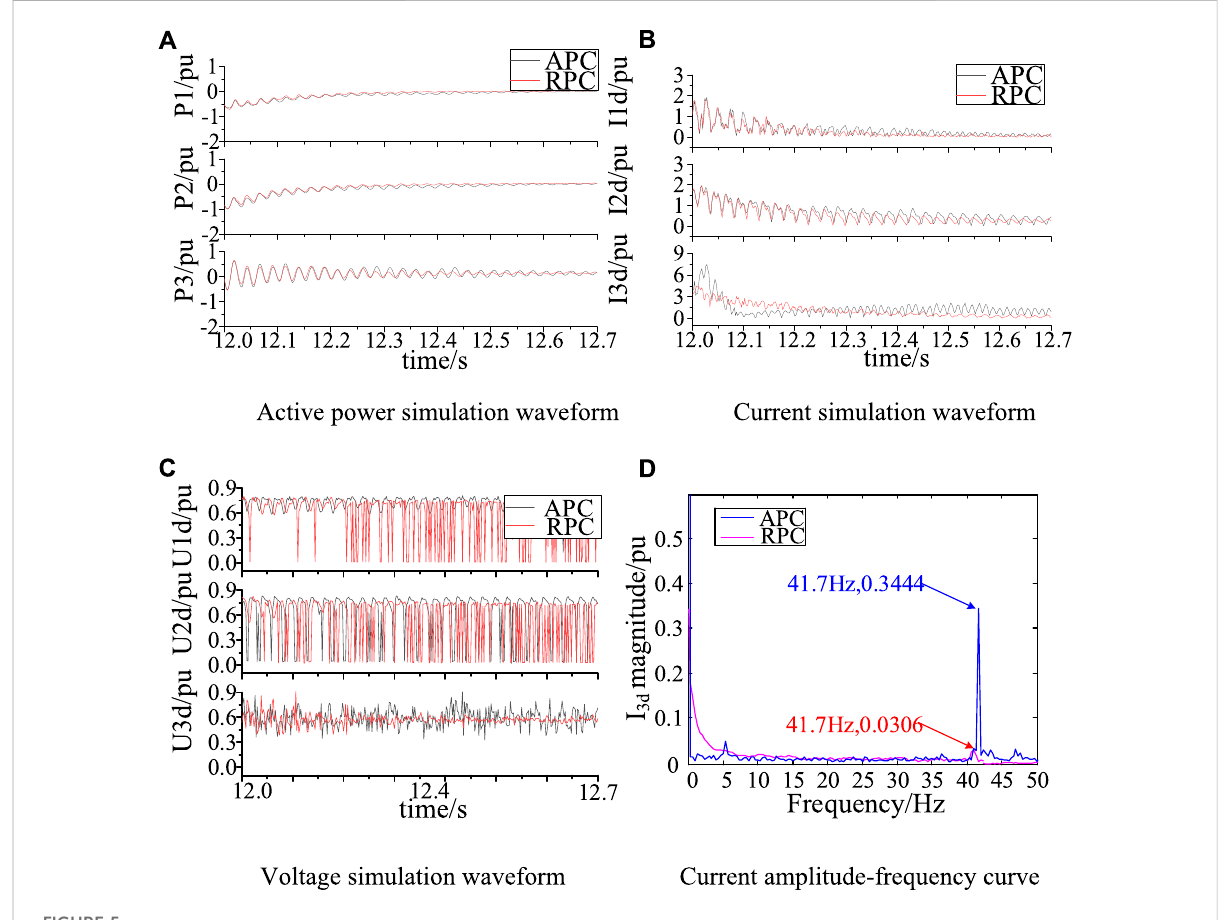
FIGURE 5 SimulationsatdifferentmonitorpointswithcontrolinAPCandRPC. (A) Activepowersimulationwaveform (B) Currentsimulationwaveform (C) Voltage simulation waveform (D) Current amplitude-frequency